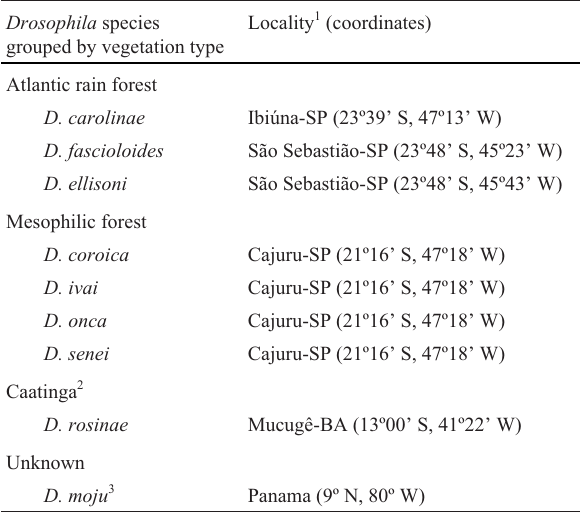
Table 1 - The Drosophila species of the fasciola subgroup used in this study, collection localities and type of